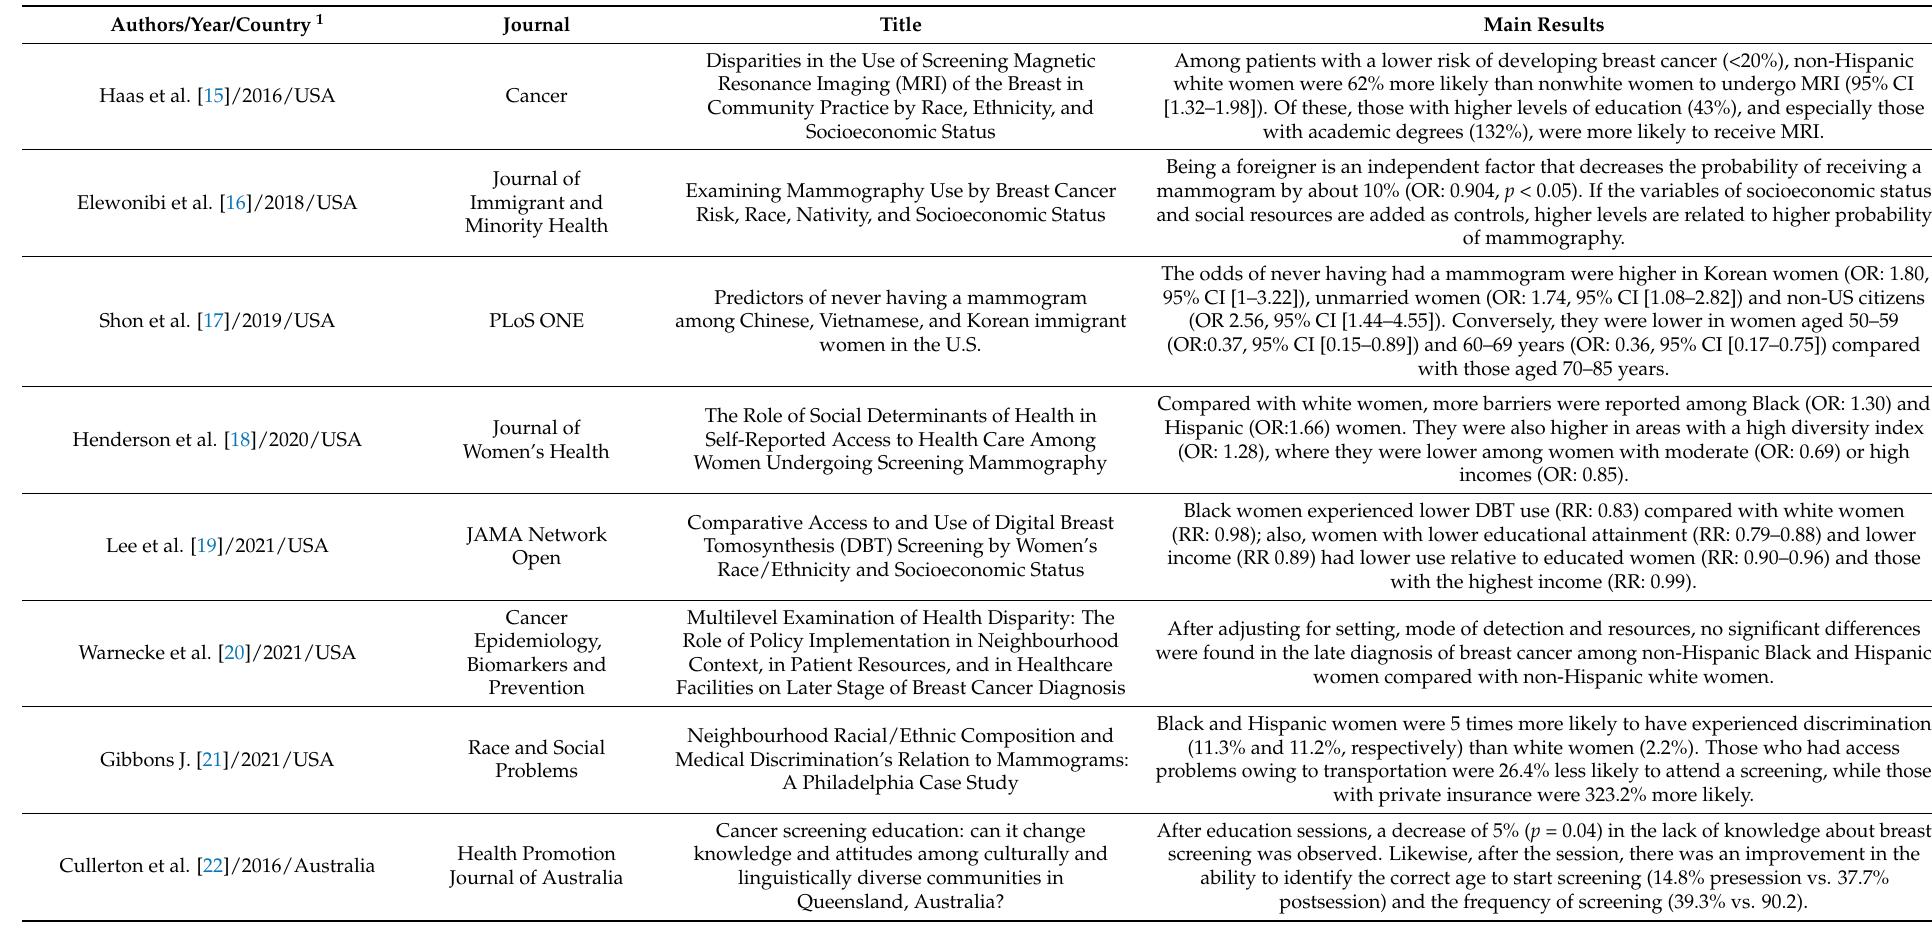
Table 1. Main results of the 17 studies included in the